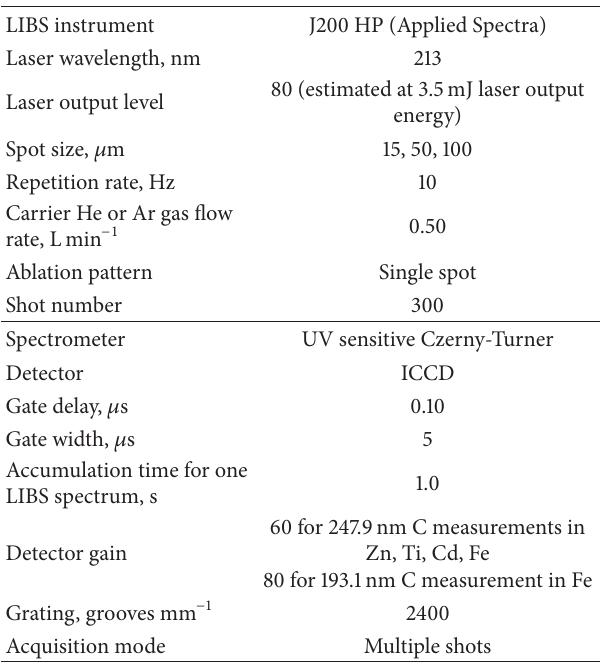
Table 1: Operating conditions of tandem LA/LIBS instrument (J200